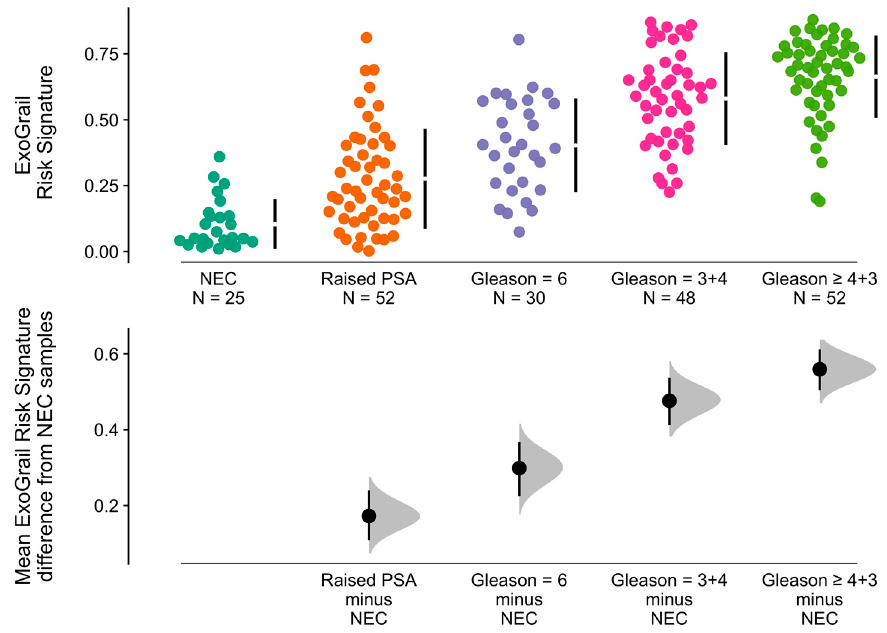
Figure 4. Mean ExoGrail risk score differences between biopsy outcomes, as represented by Cumming estimation plots. Individual patient risk scores (y-axis) are presented as points in the top panel, separated according to Gleason score (x-axis) with gapped vertical lines detailing the mean and standard deviation of each clinical group’s ExoGrail risk score. Mean ExoGrail risk score differences relative to the no evidence of cancer (NEC) group are shown in the bottom panel. Mean difference and 95% confidence intervals are shown as a point estimate and vertical bar, respectively, with density plots generated from 1000 bias-corrected and accelerated bootstrap resamples.